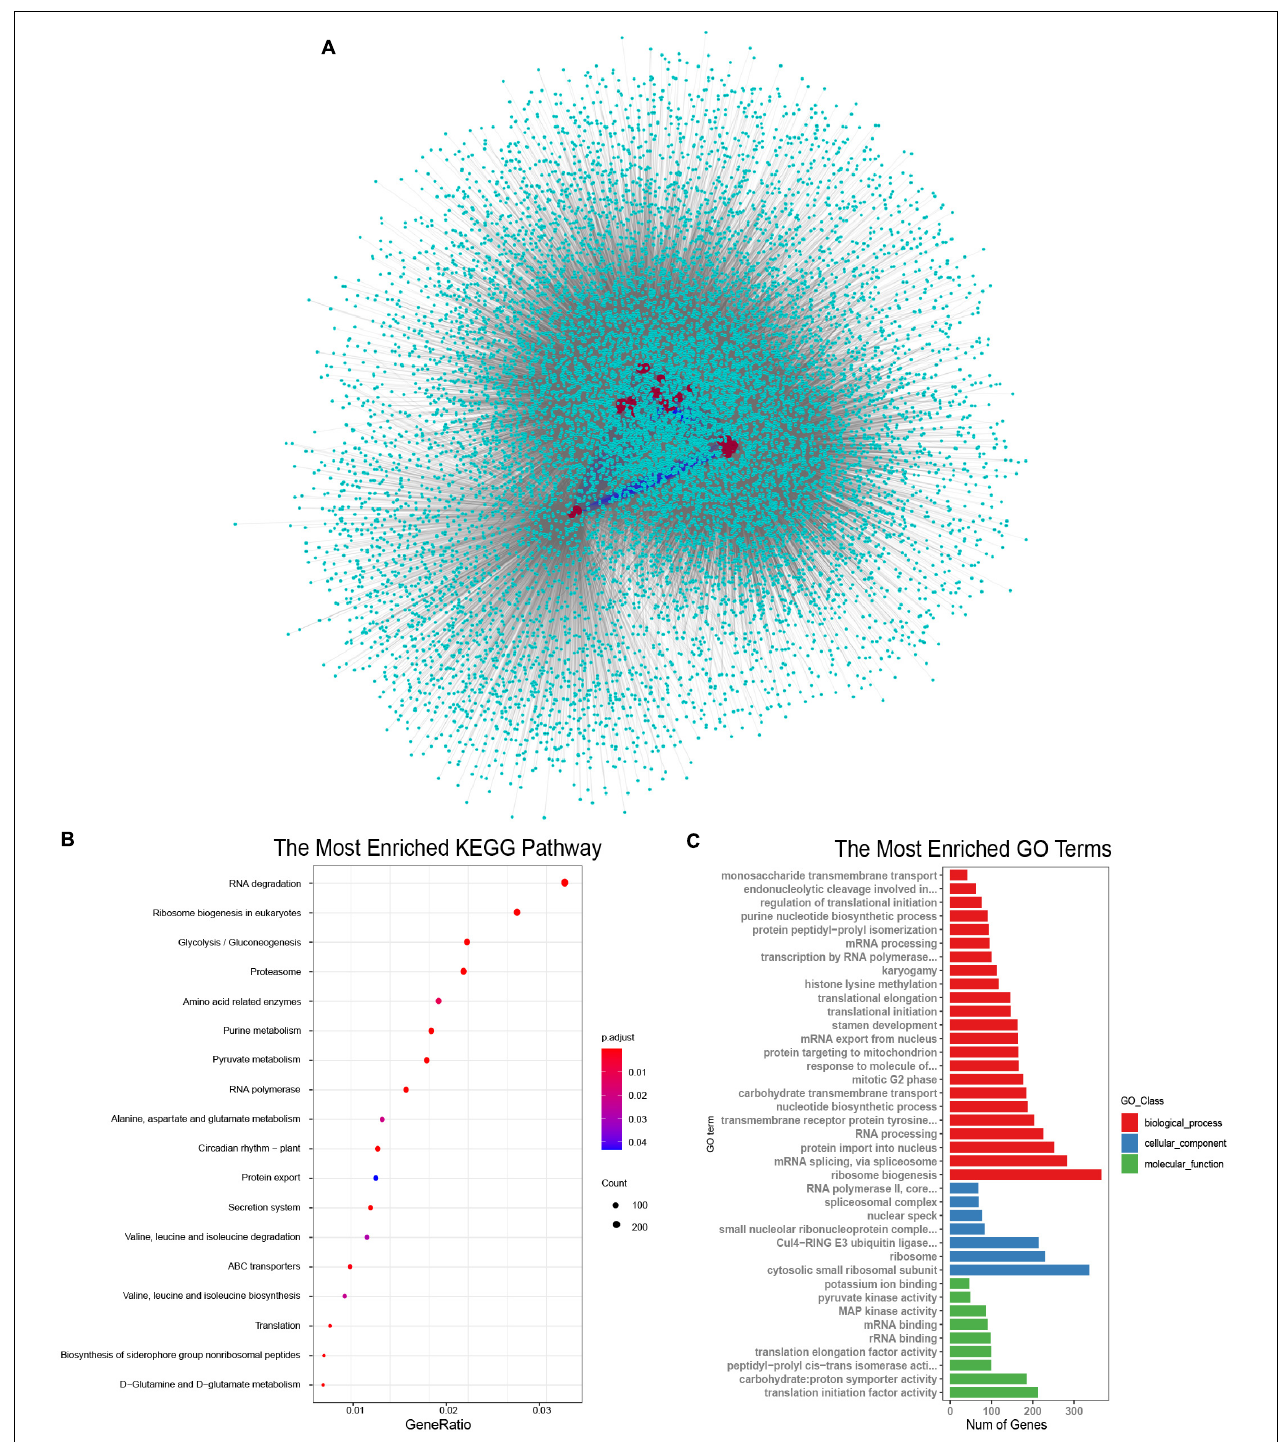
FIGURE 5 | Proteins interacted with SR proteins in B. napus . (A) Protein-protein interaction network of SR proteins in B. napus . The red circles represented the SR proteins, the indigo circles represented proteins that interacted with SR proteins. The blue lines represented the interaction between SR proteins, and the gray lines represented the interaction between SR proteins and other proteins. (B) KEGG pathway enrichment analysis of proteins interacted with SR proteins. (C) Gene Ontology enrichment analysis of proteins interacted with SR proteins.